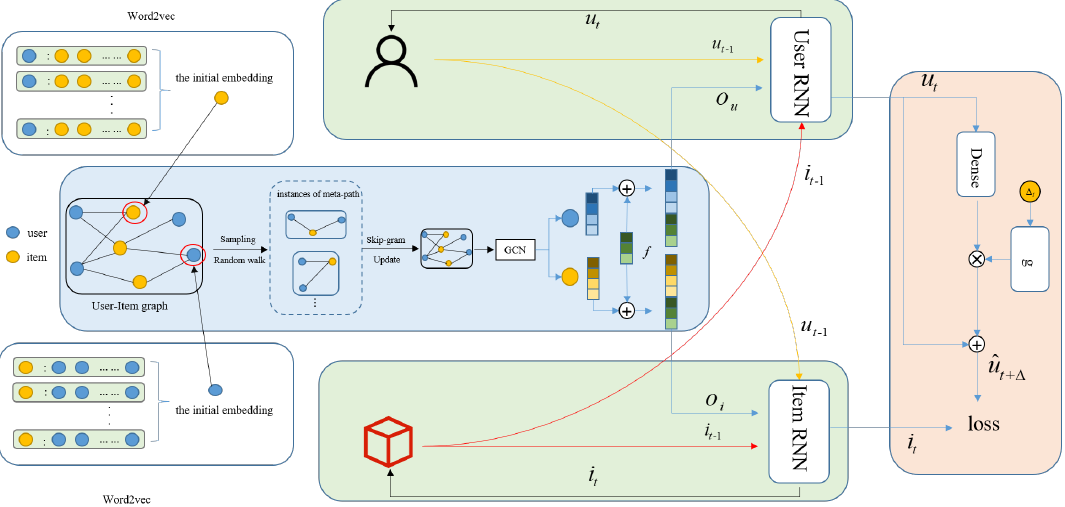
Figure 2. The framework of the proposed MRRNN-S.